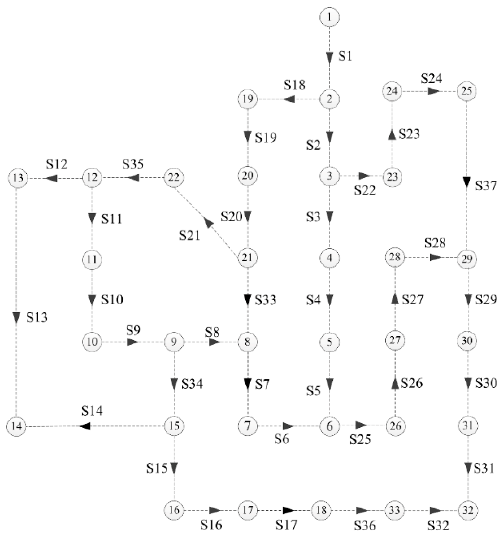
Figure 2. IEEE 33-bus distribution system [7]. Table 1. Performance analysis of proposed ASFLA on the 33-bus system.